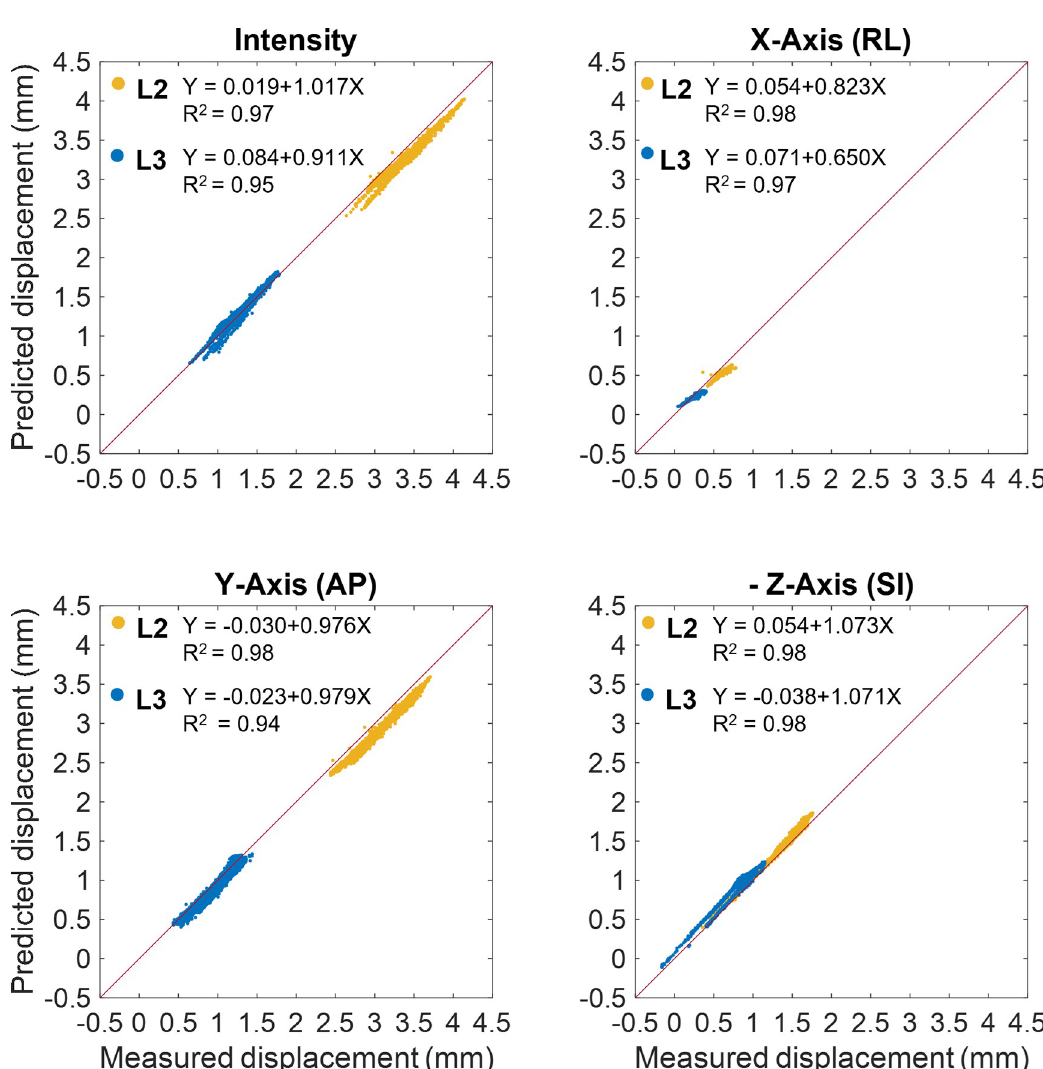
Fig 4. Linear regressions plots between predicted and experimental local displacements. Comparison between the displacements measured using DIC and the ones predicted by the FE model for L2 (yellow) and L3 (blue) vertebral surfaces. The Euclidean norms of the displacements, referred as Intensity, and the three displacement components defined in the FE model coordinate reference system are plotted. Linear regression and coefficient of determination are also reported for the correlation plots. It is important to notice that the SI component is plotted with the sign changed to allow comparison with the other